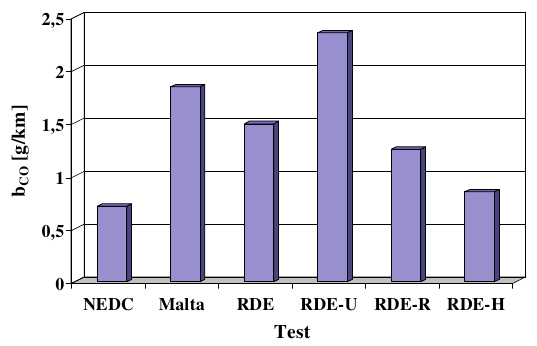
Fig. 8. Mean carbon monoxide road emissions – b CO in each of the test cycles